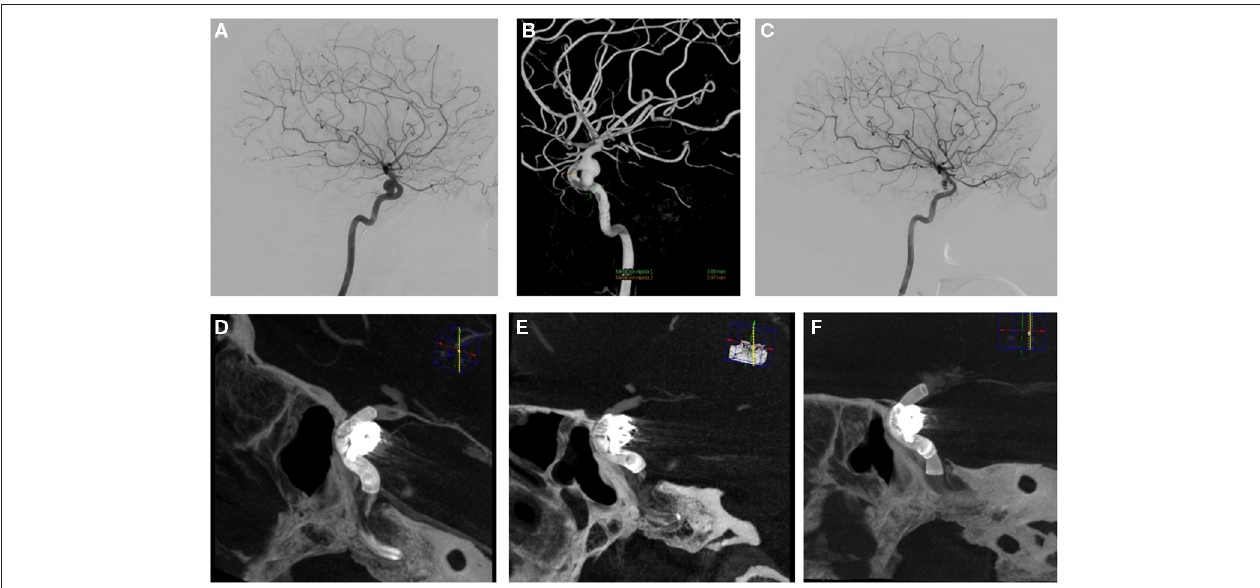
FIGURE 3 | A 52-year-old woman referred for embolization of an incidental aneurysm. Digital subtraction angiography (A) and 3D rotational angiography (B) show a wide-neck left para-ophthalmic aneurysm. Stent deployment (SV 4 × 20mm) and compartmental coiling (semi-jailing technique) was performed (C) . A Vaso CT shows adequate stent apposition to the vessel covering of the aneurysm neck (D) . A follow-up at 3 months, shows shortening of SV without completely covering the aneurysmatic neck (E) . An overlapping 4 × 25mm SV was deployment covering of the aneurysm neck (F)